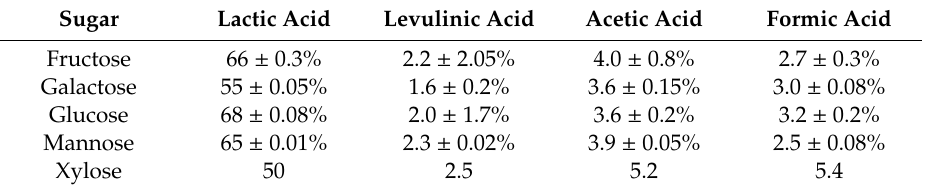
Table 5. Reaction yields of various sugars using Sn-Beta and CaSO 4 (200 ◦ C reaction temperature, 5 h batch reaction time, 2:1 catalyst to sugars ratio; uncertainties are based on one standard deviation). Sugar Lactic Acid Levulinic Acid Acetic Acid Formic Acid Fructose 66 ± 0.3% 2.2 ± 2.05% 4.0 ± 0.8% 2.7 ± 0.3% Galactose 55 ± 0.05% 1.6 ± 0.2% Glucose 68 ±